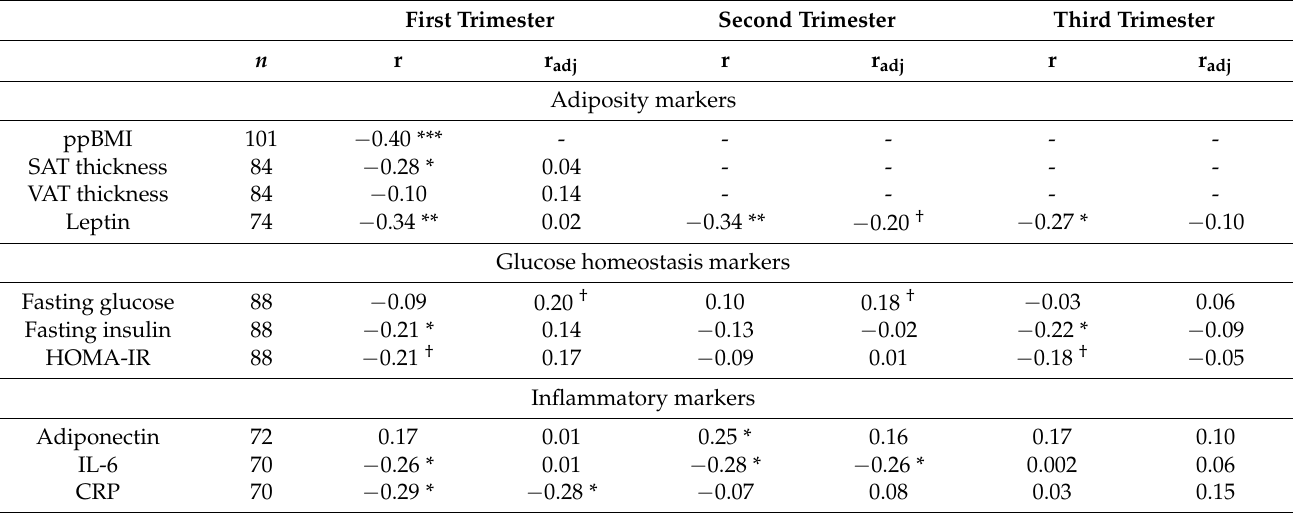
Table 4. Trimester-specific associations between albumin and metabolic